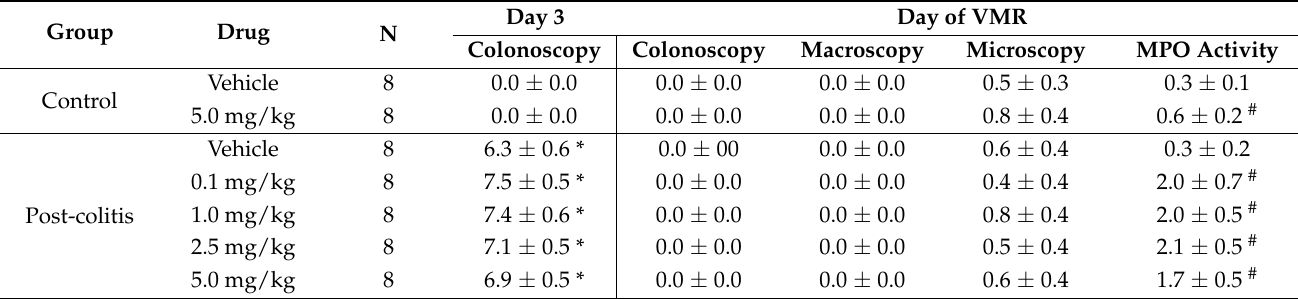
Table 2. Inflammatory parameters in the colon of post-colitis and control